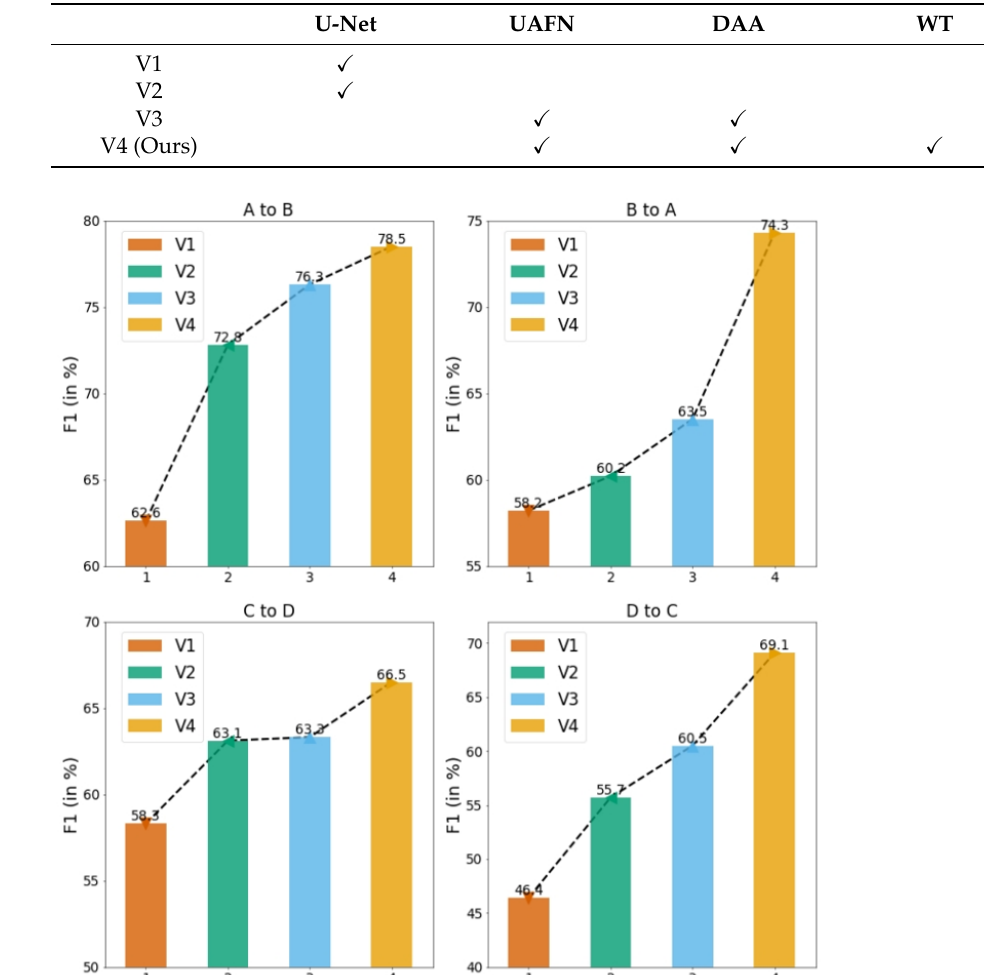
Table 2. Structural decomposition.